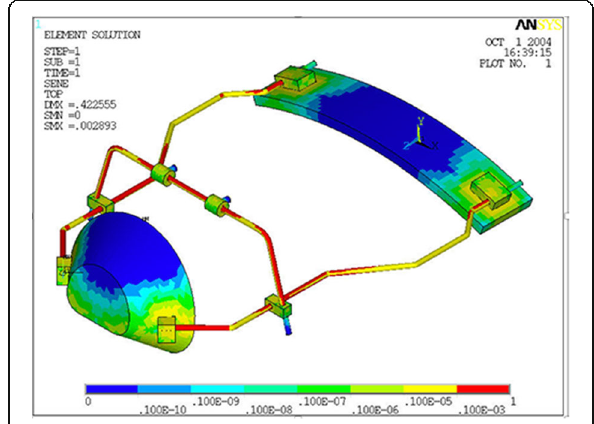
Fig. 3 Stress distribution on the FM structure. Greater stresses were assessed on the lateral bars of the structure